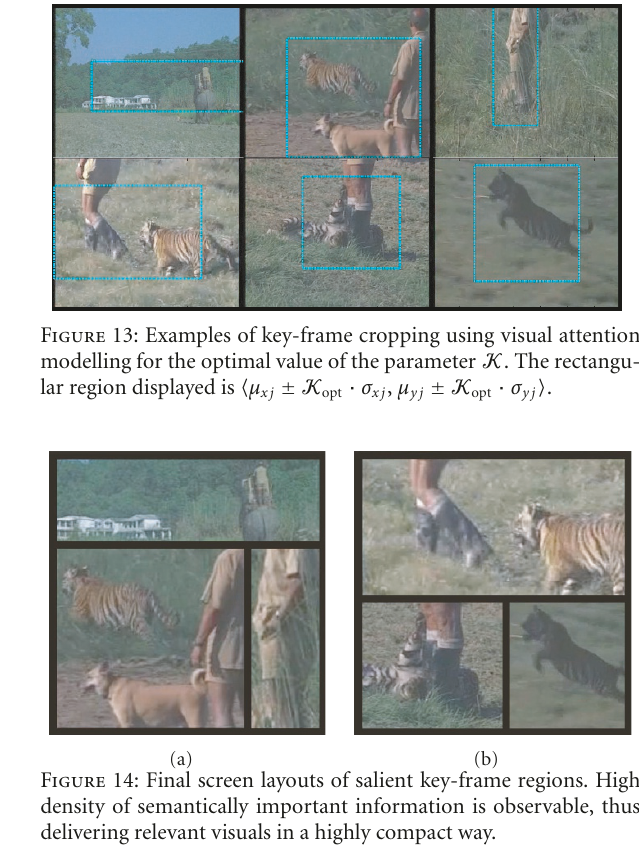
Figure 14: Final screen layouts of salient key-frame regions. High density of semantically important information is observable, thus delivering relevant visuals in a highly compact